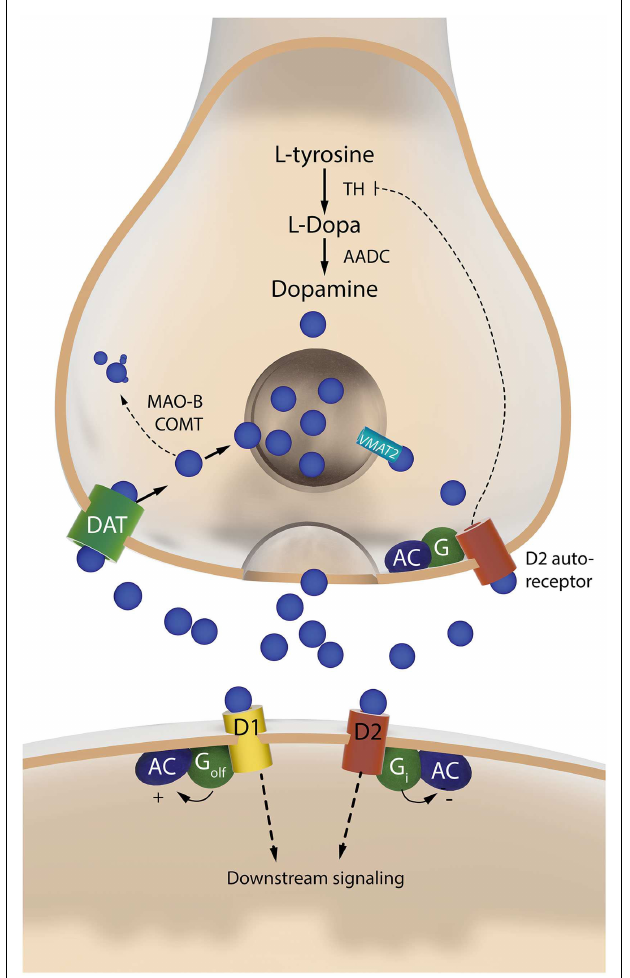
FIGURE 3 |The two sides of a dopaminergic synapse .The drawing illustrates components of the nigrostriatal dopaminergic synapse that are discussed in this article.The presynaptic nigrostriatal terminal releases DA (blue circles), and regulates extracellular DA levels through several mechanisms: DA reuptake from the extracellular fluid (via the DAT), DA transport into synaptic vesicles (viaVMAT-2), DA synthesis (which is subjected to autoregulatory control via presynaptic D2 receptors), and DA metabolism (via MAO-B and COMT).The post-synaptic neuron responds to DA via two main types of receptors.The D1 receptor is coupled to G olf and activates c-AMP-dependent intracellular signaling pathways.The D2 receptor is coupled to G i and inhibits the same pathways. AADC, aromatic L-amino acid decarboxylase; AC, adenylate cyclase; COMT, catechol-O-methyl-transferase; DAT, dopamine transporter; MAO-B, monoamine oxidase B;TH, tyrosine hydroxylase;VMAT-2, vesicular monoamine transporter 2.